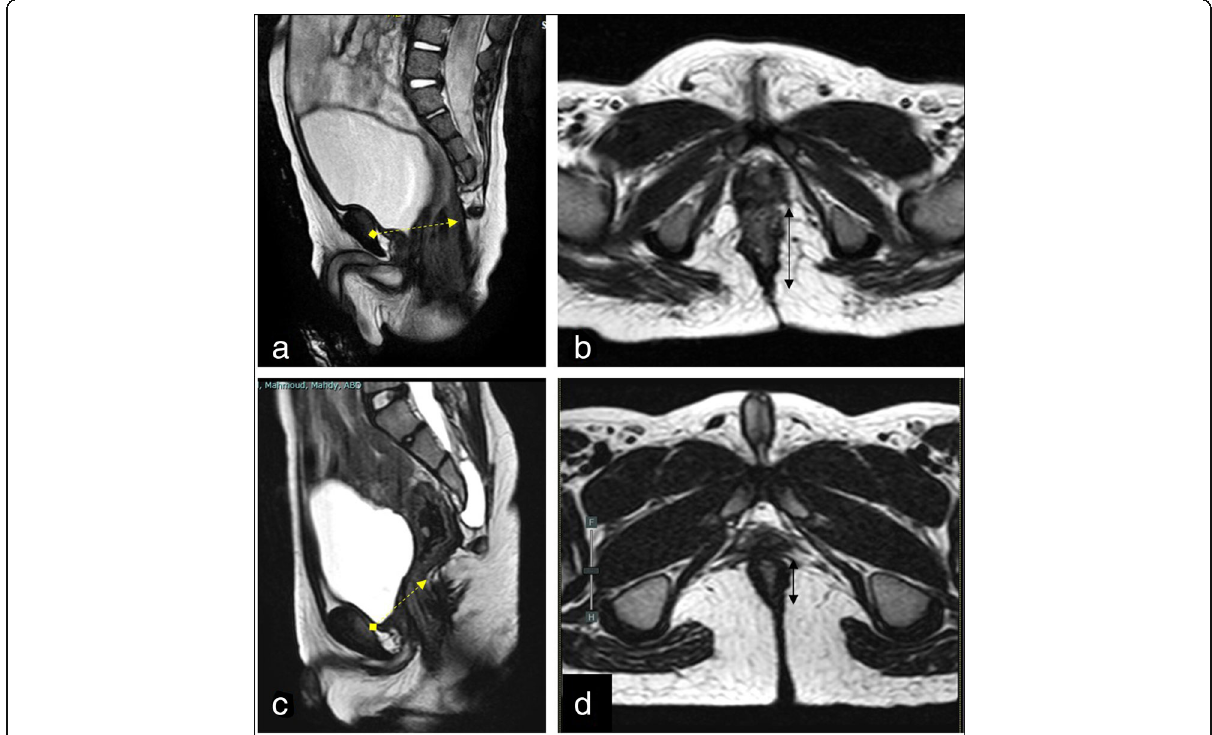
Fig. 3 Demonstration of the effect of reoperation (redo PSARP) on rectifying the distorted internal pelvic anatomy. Upper row (before reoperation): pelvic MRI of 19-month-old boy presenting with complications after a previous PSARP (before closure of colostomy). a Midsagittal MRI demonstrating very wide pelvic hiatus (almost occupying the entire anteroposterior diameter of bony pelvis) with flat anorectal angle.